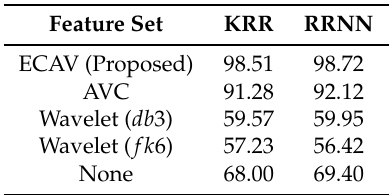
Table 3. Testing accuracy as % (for d =